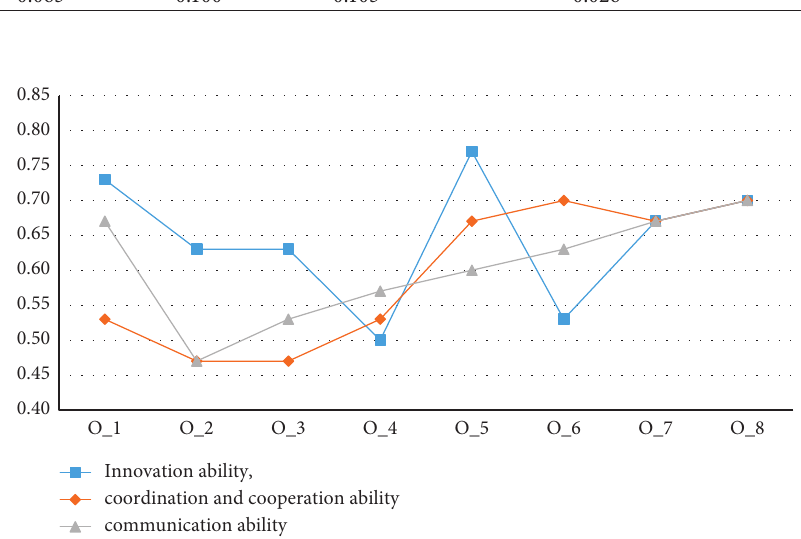
Figure 6: Competency levels for each